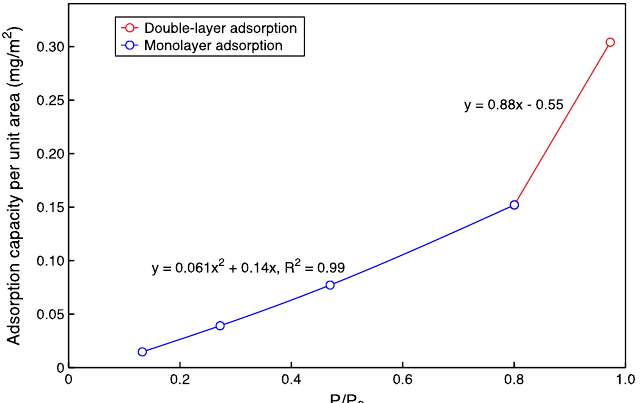
Figure 7. The mathematical model for predicting the amount of hydrocarbons adsorbed per unit area of kaolinite at 313 K.